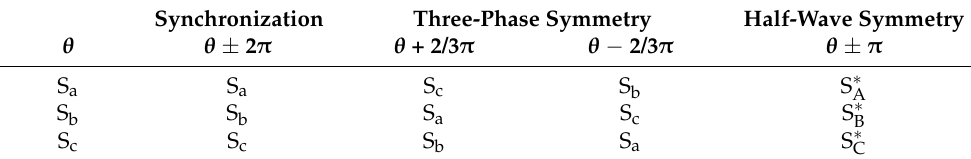
Table 2. Condition of synchronization and symmetry in term of switching